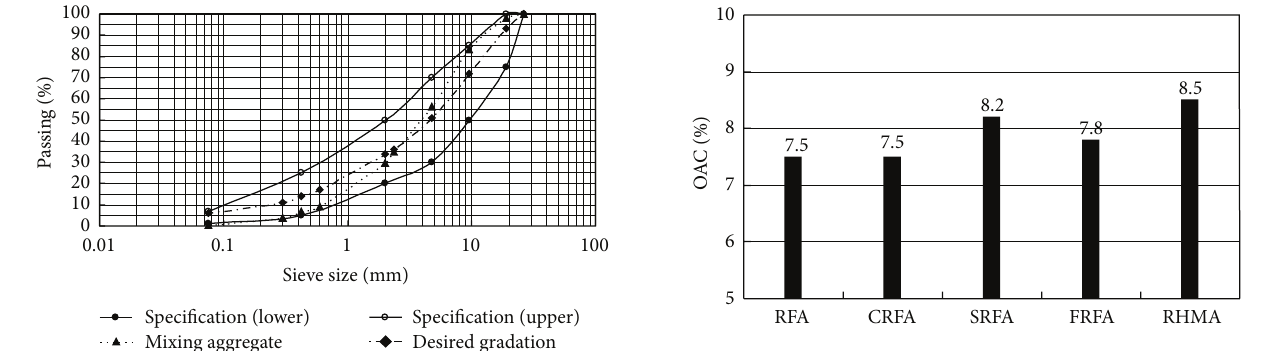
Figure 5: Optimum asphalt content of each